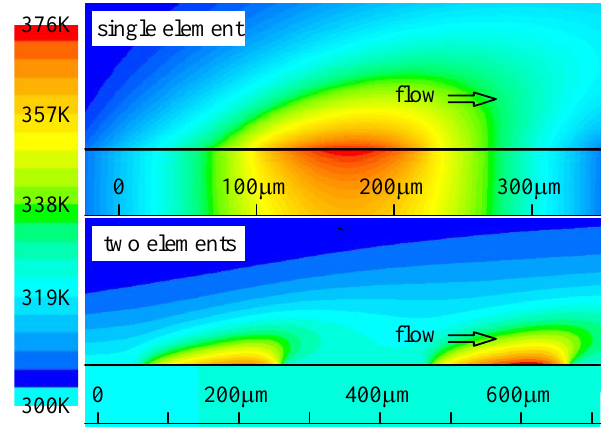
Figure 2. Temperature distribution above the surface of thermal